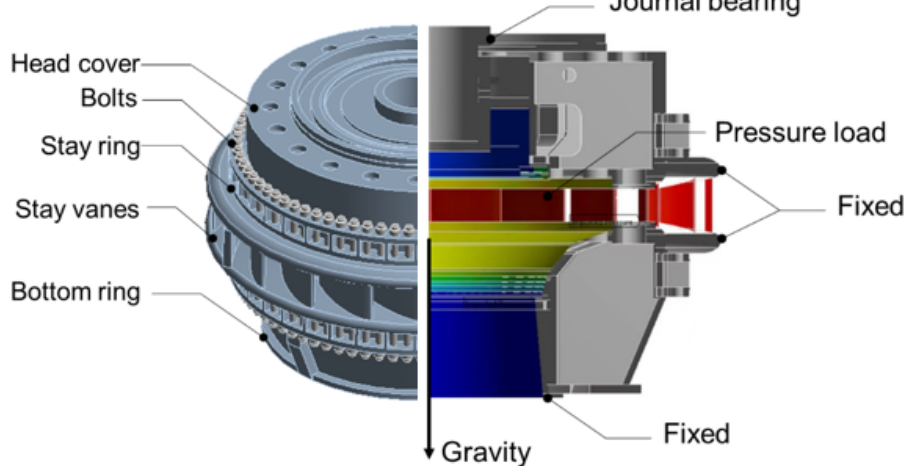
Figure 9. Setup of the non-rotating structures for flow-induced vibration